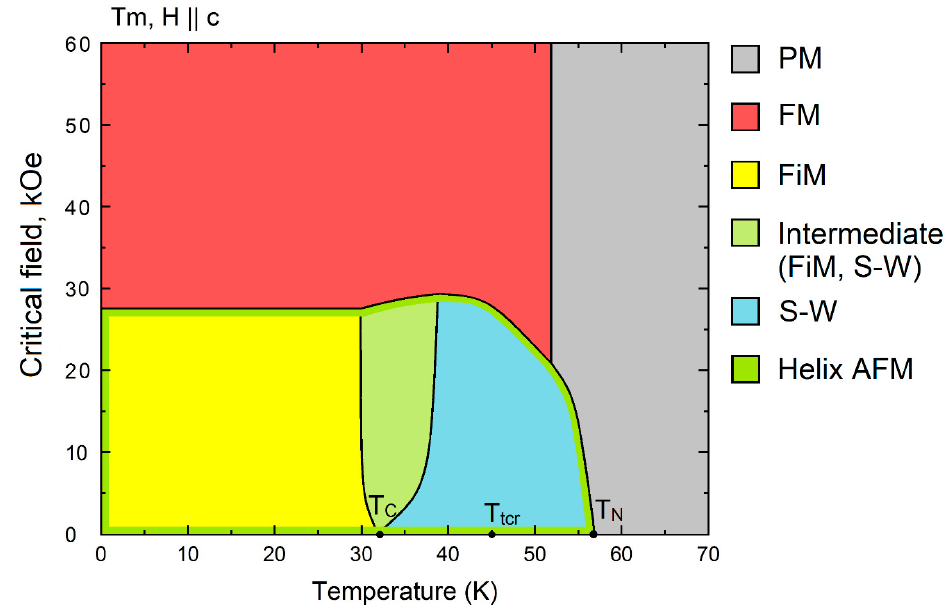
Figure 7. Magnetic phase diagram of Tm. The experimental data has been taken from [118].